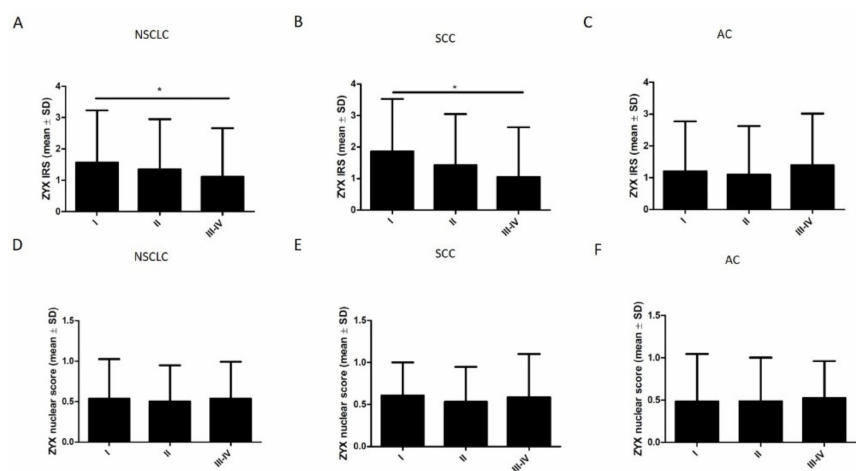
Figure 11. Immunohistochemistry (IRS, nuclear score) of ZYX expression at different clinical stages of cancer. The analysis for the whole NSCLC group ( A , D ), SCC ( B , E ), and AC ( C , F ) subtypes. Dunn’s multiple comparisons test (* p < 0.05).